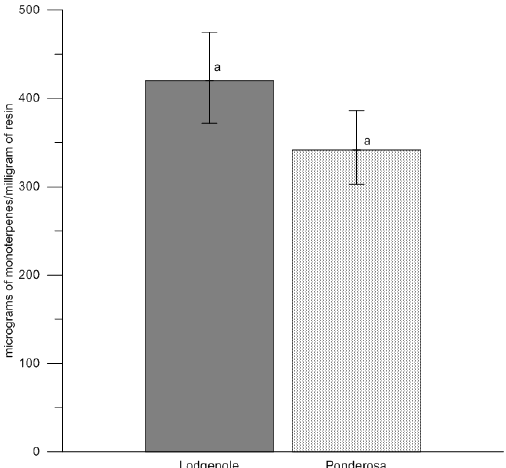
Figure 2. Total cumulative constitutive terpenoid concentrations (mean ug/mg oleoresin ± 1/2 LSDs) from lodgepole pine ( P. contorta var. latifolia ) and ponderosa pines ( P. ponderosa ) in the Colorado Front Range. Differing letters indicate significance p < 0.05 determined from a non ‐ parametric ANOVA corrected using Exact Wilcoxon tests (Proc NPAR1WAY; SAS). n = 20.